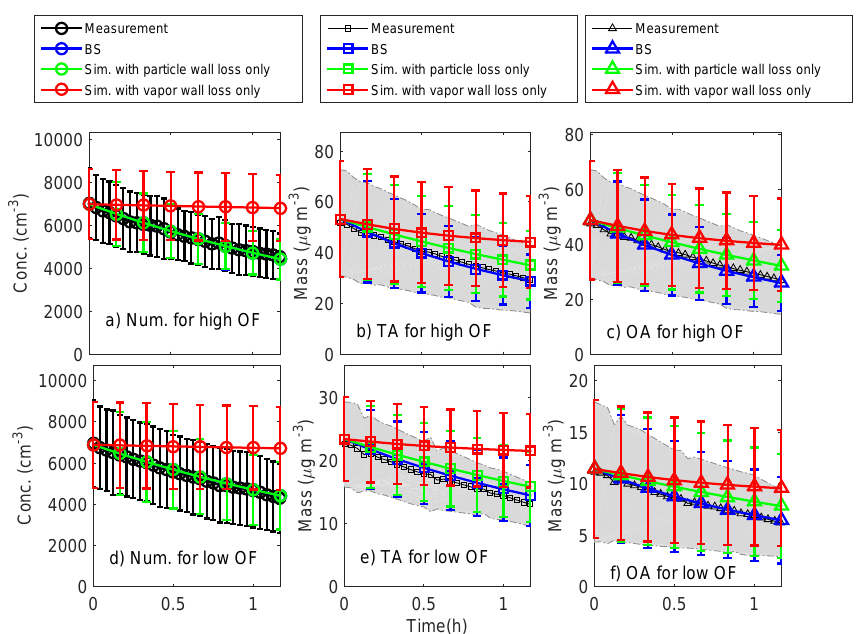
Figure 2. Comparison between the average of the measurements and the average of the model simulations of the 18 experiments for (a) par- ticle number concentration (cm − 3 ) , (b) total submicron aerosol mass concentration (TA, µgm − 3 ) and (c) organic aerosol mass concentration (OA, µgm − 3 ) for the burns with high aerosol organic mass fraction, OF>0.8; (d) – (f) as in (a) – (c) , but for the burns with low aerosol organic mass fraction, OF<0.8. Burns with OF>0.8 included burns 37, 38, 40, 47, 51, 57, 61, 65 and 66; the low-OF experiments were burns 42, 43, 45, 49, 53, 55, 59, 63, and 67. The error bars and shaded areas represent 1 standard deviation in the measurements and the model simulations, respectively, and represent variations between the various experiments rather than